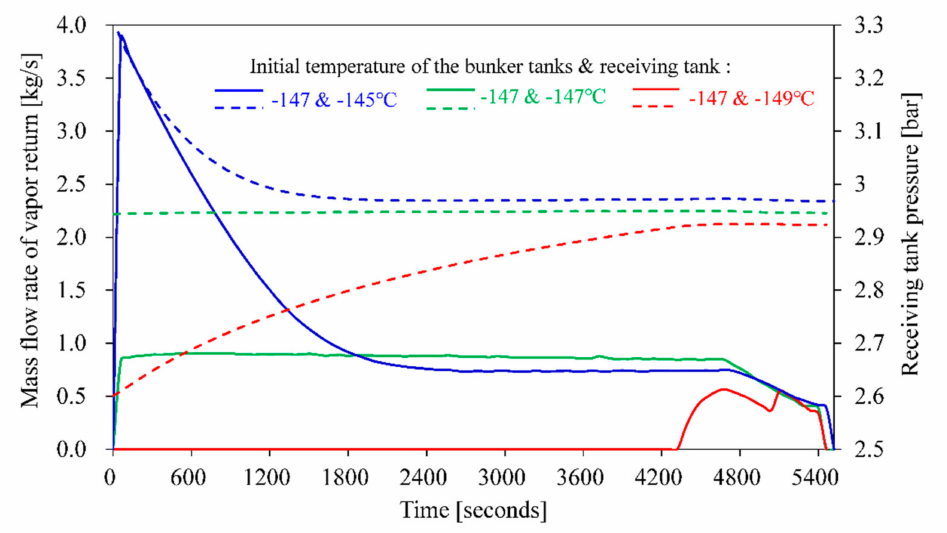
Figure 4. Variation of vapor return flow rates and receiving tank pressure at receiving tank initial temperature, − 145, − 147, − 149 ◦ C (solid line: mass flow rate of vapor return, dotted line: receiving tank